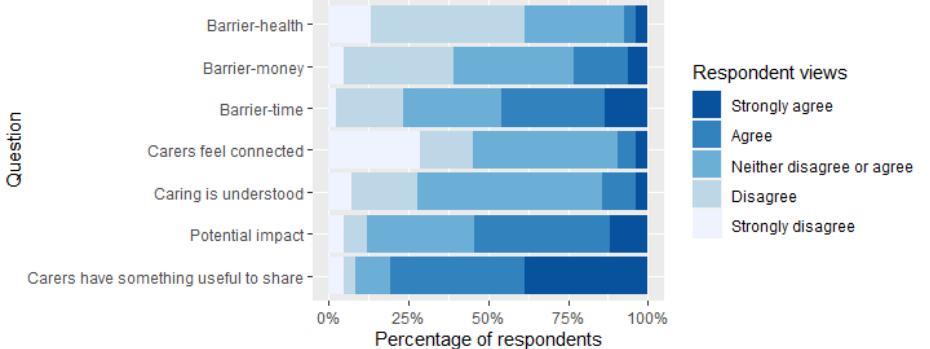
Figure 1. Caregiver responses to a range of statements according to whether they “Strongly agree”, “Agree”, “Neither disagree or agree”, “Disagree” and “Strongly Agree”. Statements focused on whether: (i) caregivers have something